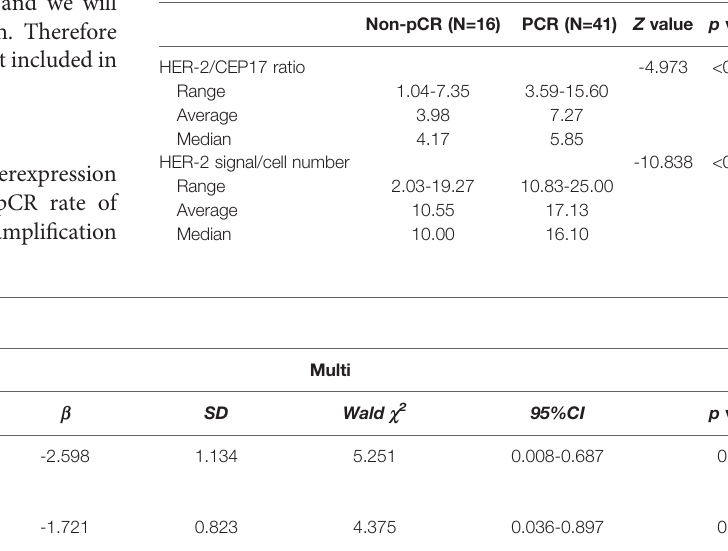
TABLE 3 | FISH and pCR